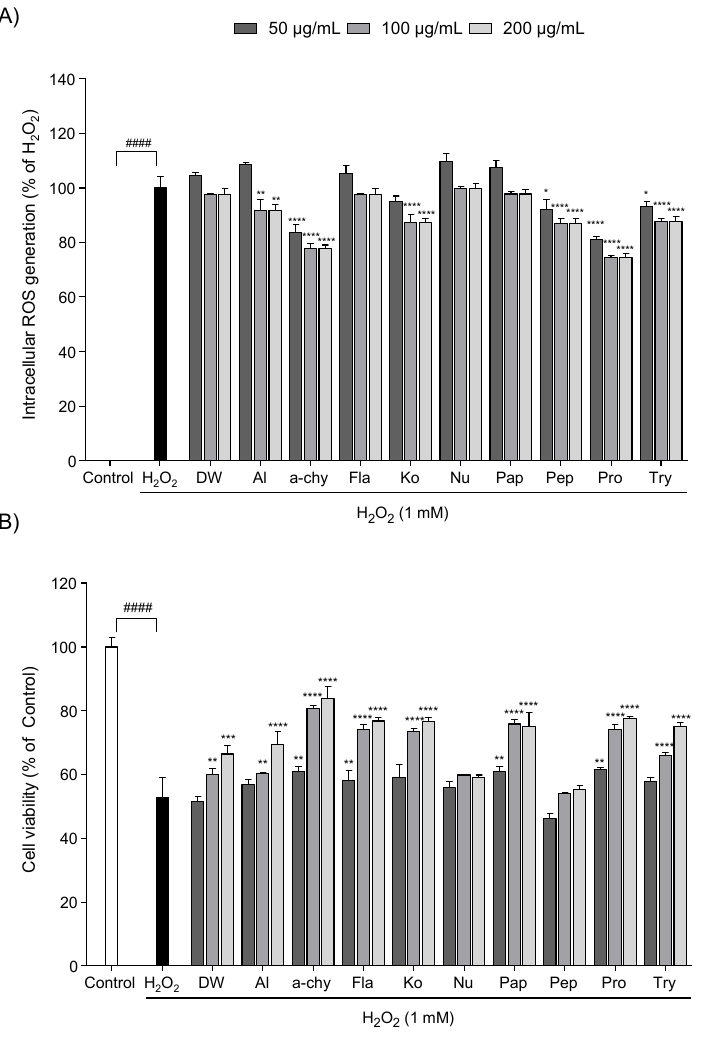
Figure 1. Protective effect of SJH against H 2 O 2 induced oxidative stress. Intracellular reactive oxygen species (ROS) scavenging activity ( A ) and cell viability ( B ) in H 2 O 2 exposed Vero cells. Experi- ments were performed in triplicate and data are expressed as mean ± SD; Significant differences identified at * p < 0.05, ** p < 0.01, *** p < 0.001 and **** p < 0.0001 as compared to the H 2 O 2 treated group; #### p < 0.0001 as compared to the control group. Statistical analyses were conducted using Tukey’s post hoc comparison and Duncan’s multiple range test.